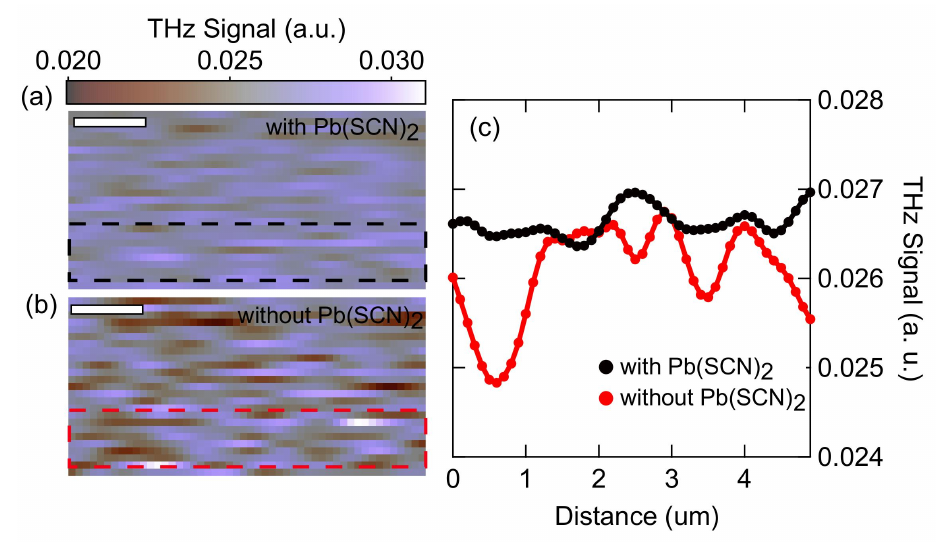
Figure 2. LTEM 2D images of MAPbI 3 perovskite thin film samples with ( a ) and without ( b ) Pb(SCN) 2 additives upon excitation with 400 nm laser pulse at the power of 6 mW and 45 degree incident angle at room temperature; ( c ) local spatial fluctuation of THz emission peak amplitude from perovskite samples with (black) and without (red) Pb(SCN) 2 additives as indicated by the black ( a ) and red ( b ) dashed rectangular